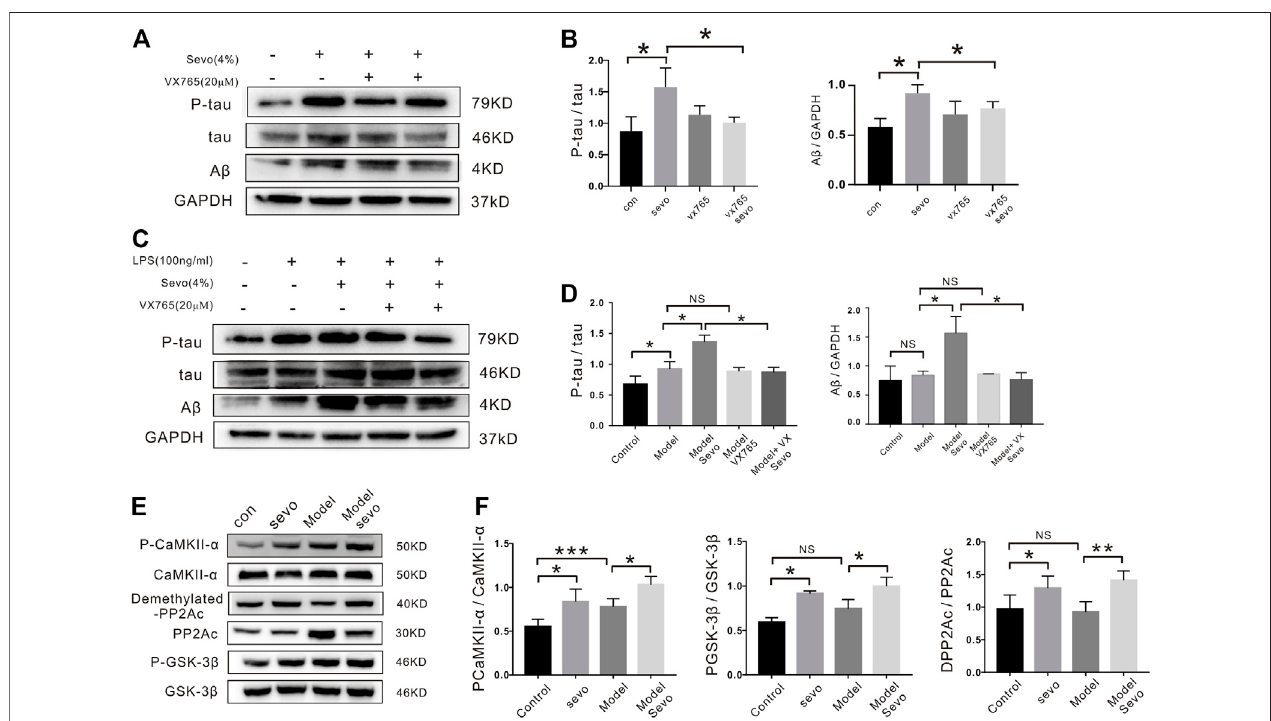
FIGURE 4 | Tau-correlated kinases and phosphatases regulate the effects of sevo fl urane in BV2 cells. (A) BV2 cells were treated with 4% sevo fl urane for 6 h, and then p-tau and A β were detected byWesternblotting. (B) . Quantitation of p-tau and A β band intensity using ImageJ software.( C ) Western blotting analysis ofp-tau and A β inducedbysevo fl uraneinBV2cellspretreatedwith100 ng/mloflipopolysaccharide(LPS). (D) .Quantitationofp-tauandA β bandintensityusingImageJsoftware. (E) Expression of tau-correlated kinases and phosphatases (P-CaMKII, PP2A-D, and P-GSK-3 β ) as determined by Western blotting analysis. (F) Quantitation of P- CaMKII, PP2A-D and P-GSK band intensity using ImageJ software. *** p < 0.001, ** p < 0.01, * p < 0.05.